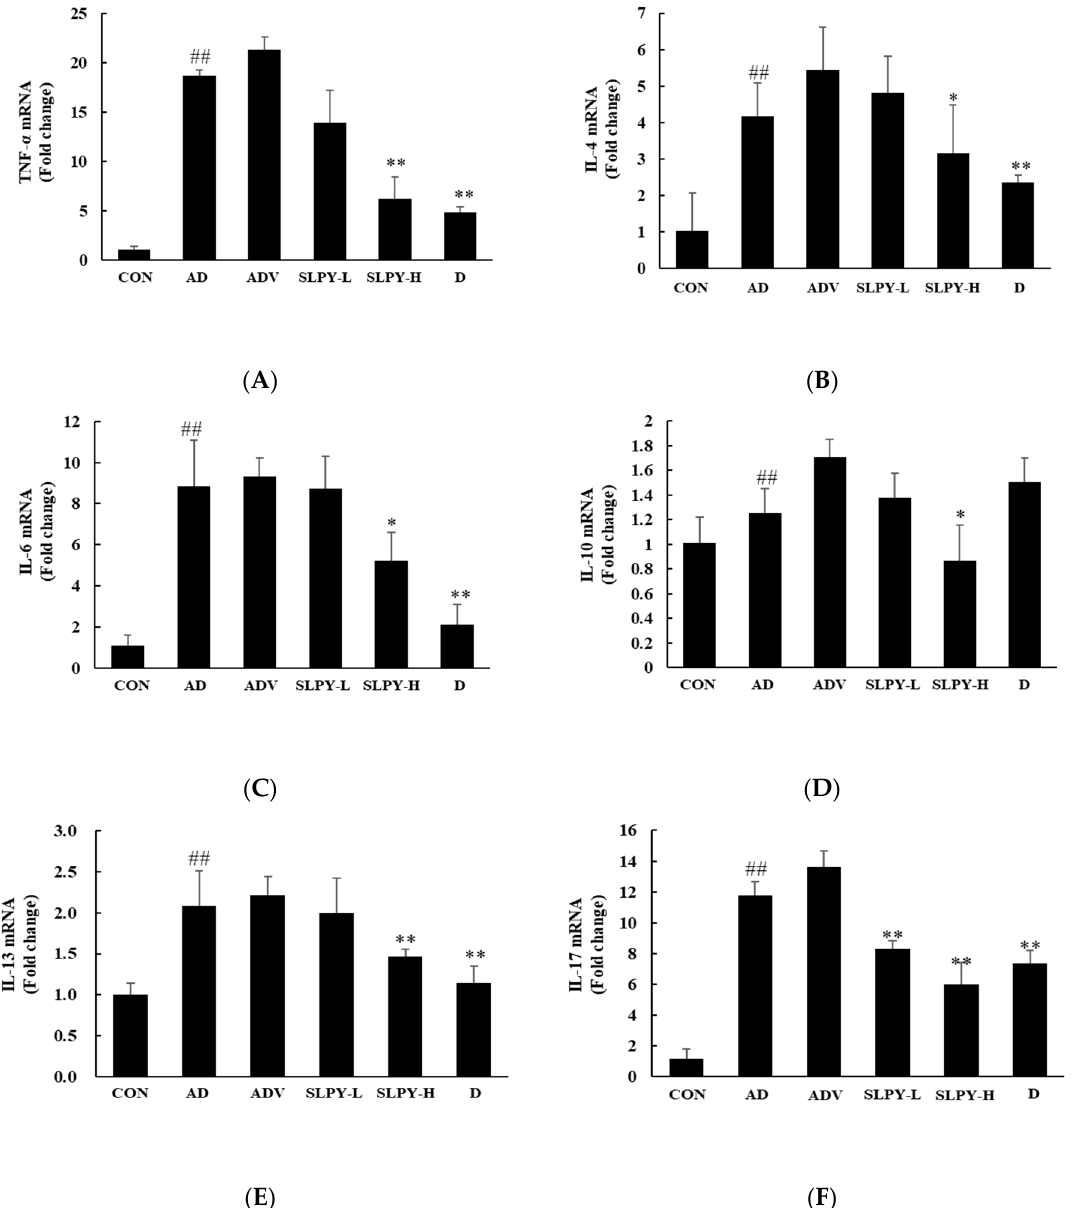
Figure 6. E ff ect of SLPY on the levels of in fl ammatory cytokine expression in the dorsal skin of DNCB-treated AD mice. ( A ) TNF- α , ( B ) IL-4, ( C ) IL-6, ( D ) IL-10, ( E ) IL-13, and ( F ) IL-17 mRNA levels of DNCB-induced AD mice with the treatment of SLPY. Data displayed as mean ± SD of at least three replicates. ## p < 0.01 vs. the corresponding control group and ** p < 0.01, * p < 0.05 vs. the corresponding AD group. CON: non-treatment group; AD: 2,4-dinitrochlorobenzene (DNCB)-induced group; ADV: combined treatment of 1% DNCB and vehicle; SLPY-L: combined treatment of 1% DNCB and 50 mg/Kg SLPY; SLPY-H: combined treatment of 1% DNCB and 100 mg/Kg SLPY; D: combined treatment of 1% DNCB and Dermatop (0.25% ( w/w ).